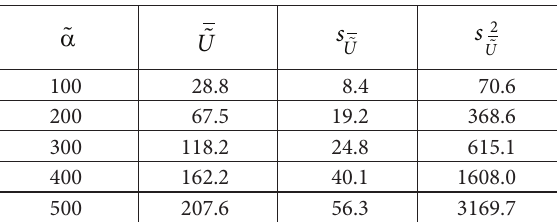
Table. The parameter values of the acoustic emission resultant signals